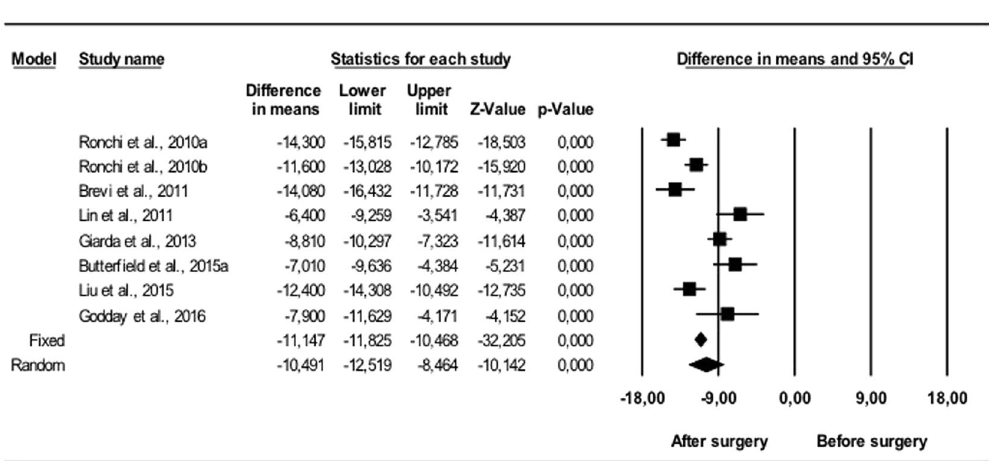
Figure 6. Changes in ESS. Decrease in Epworth sleepiness scale following bimaxillary advancement surgery.